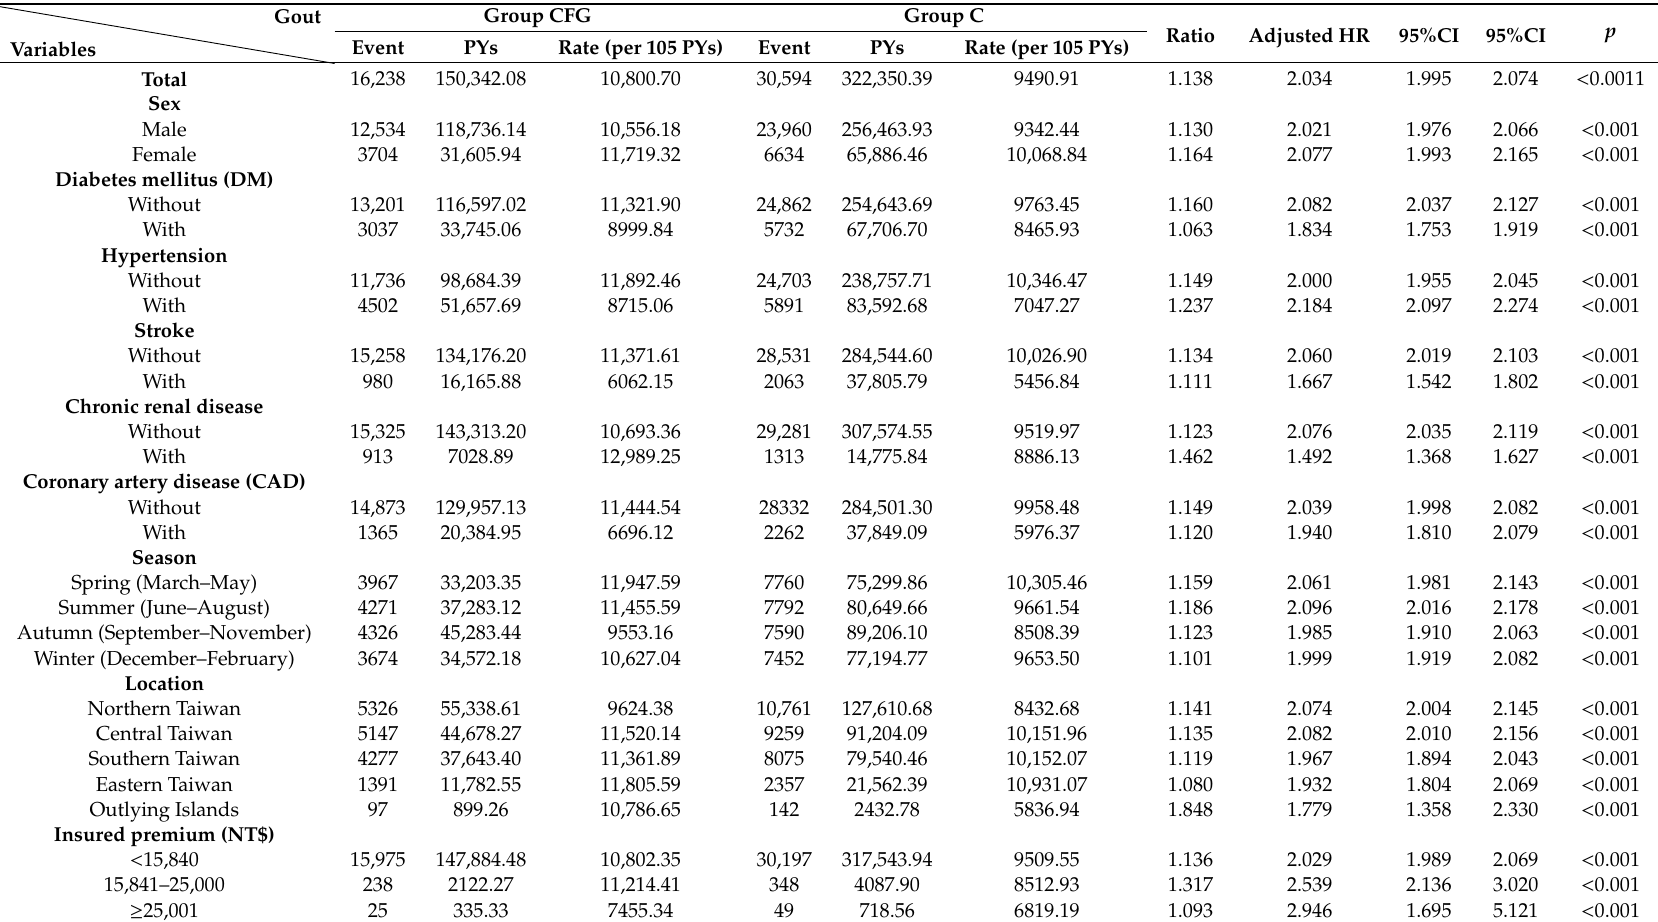
Table 4. Factors for the Occurrence of Injuries Stratified by Variable Listed in Table 1 by Cox Regression